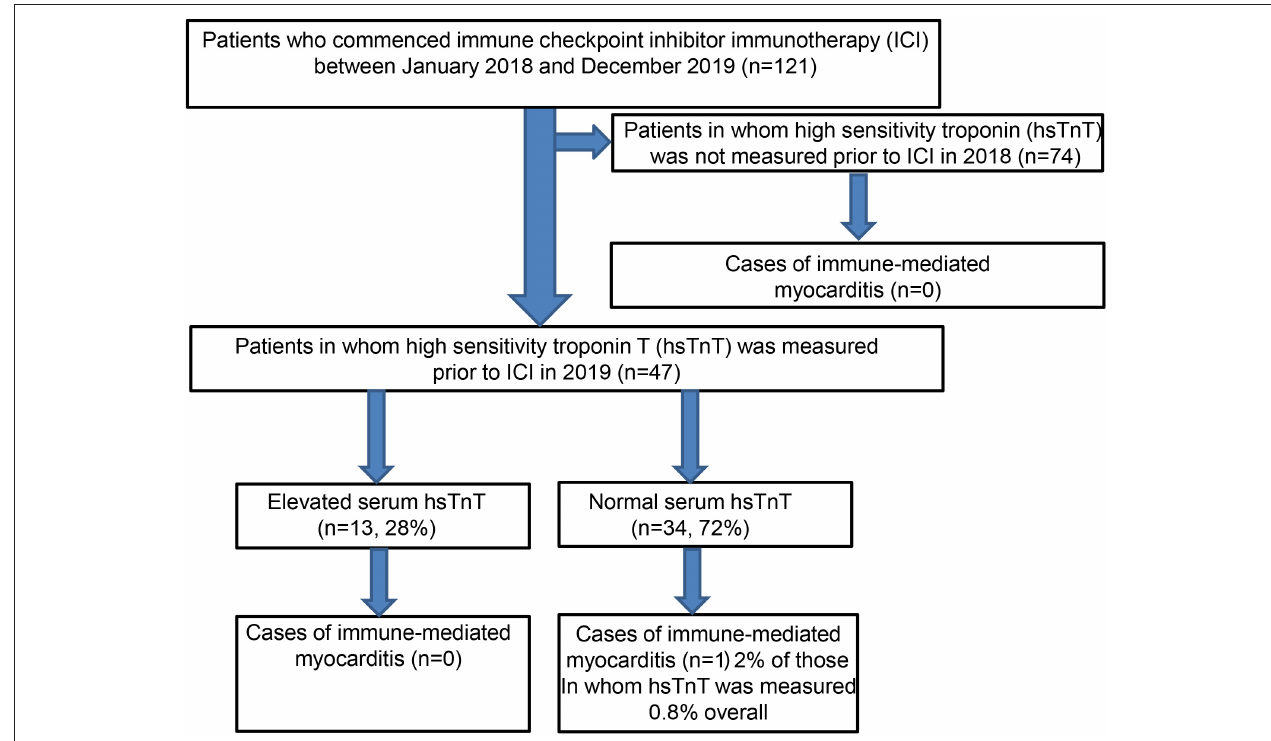
FLOW CHART | Study population.